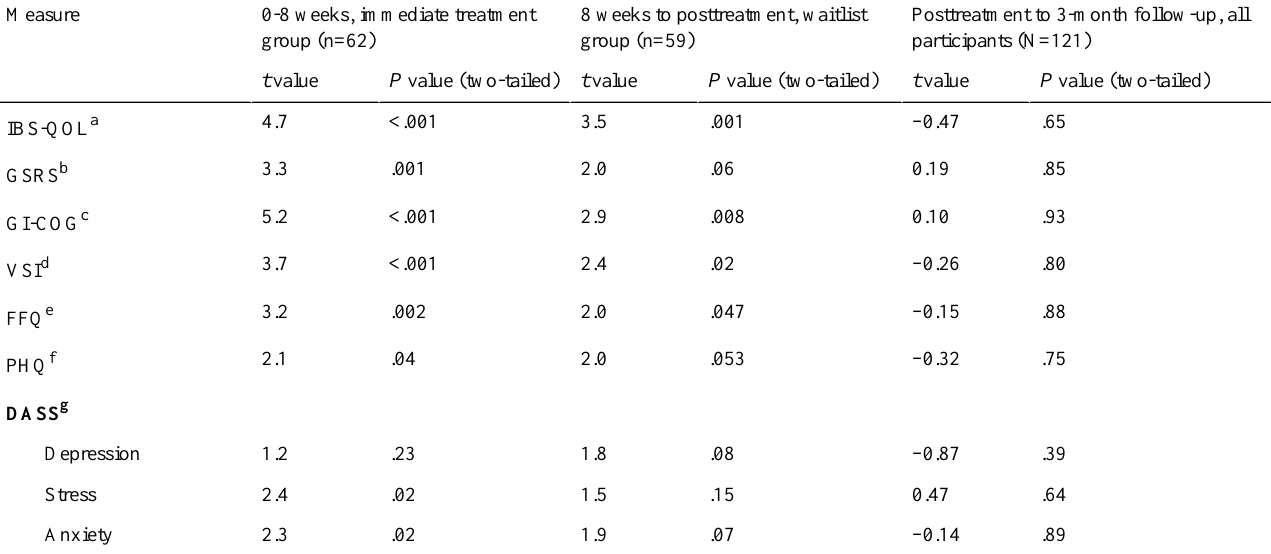
Table 7. Intention-to-treat sensitivity analysis of within-group changes using multiple imputation.